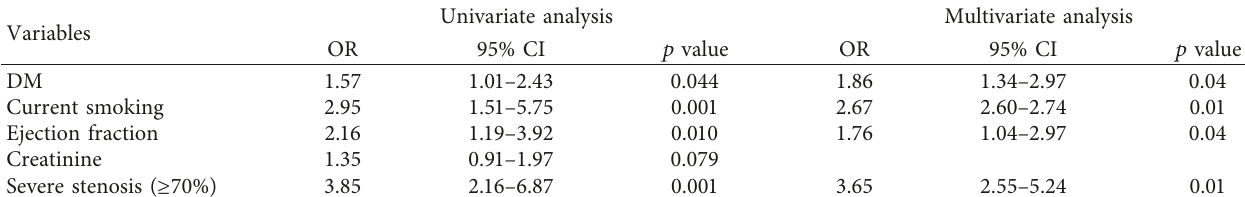
Table 6: Predictors for new native-vessel occlusion.